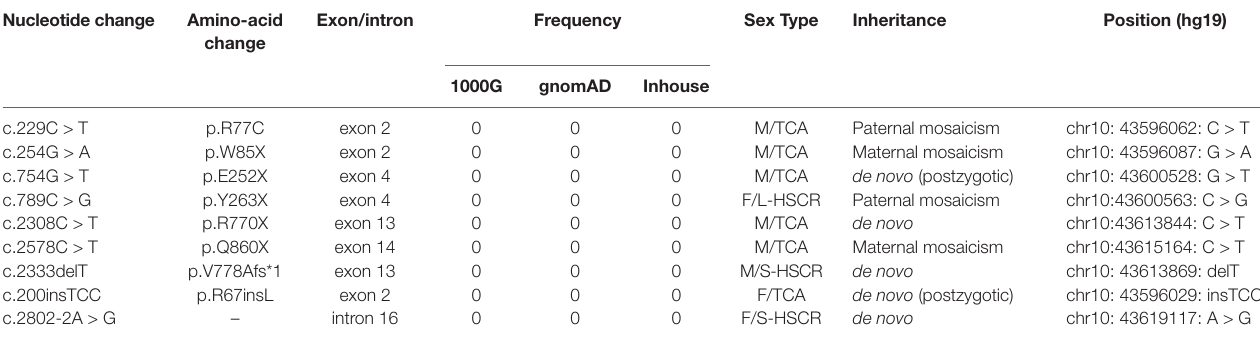
TaBle 1 | RET rare variants investigated in this